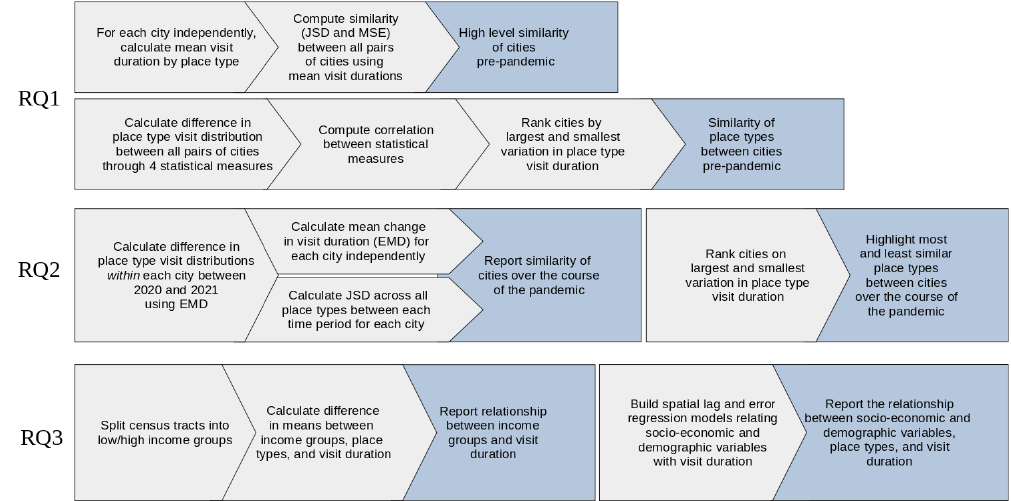
Figure 1: A graphical overview of the methodology workflow addressing each of the re- search questions